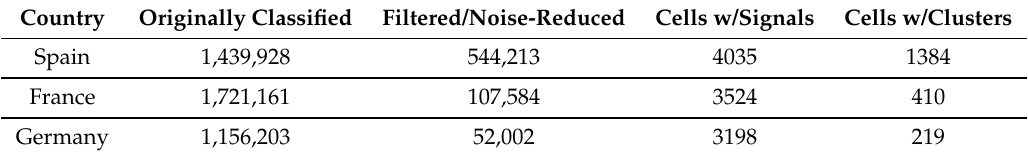
Table 1. Total numbers of streets in North America that have been mapped to Spanish, French and German streets. After a first classification, the resulting set is filtered again in order to reduce noise and remove streets that are classified by many different countries. In this way, street specifics that are used in many countries and languages are removed (i.e., popular first names). The numbers confirm the signals we see in the plots as Spanish signals are much stronger than French or German ones. Country Originally Classified Filtered/Noise-Reduced Cells w/Signals Cells w/Clusters Spain 1,439,928 544,213 4035 1384 France 1,721,161 107,584 3524 410 1,156,203 52,002 3198